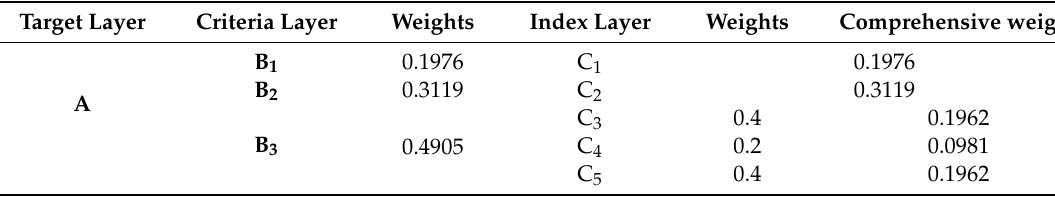
Table 12. Weight table of social and economic bearing capacity evaluation